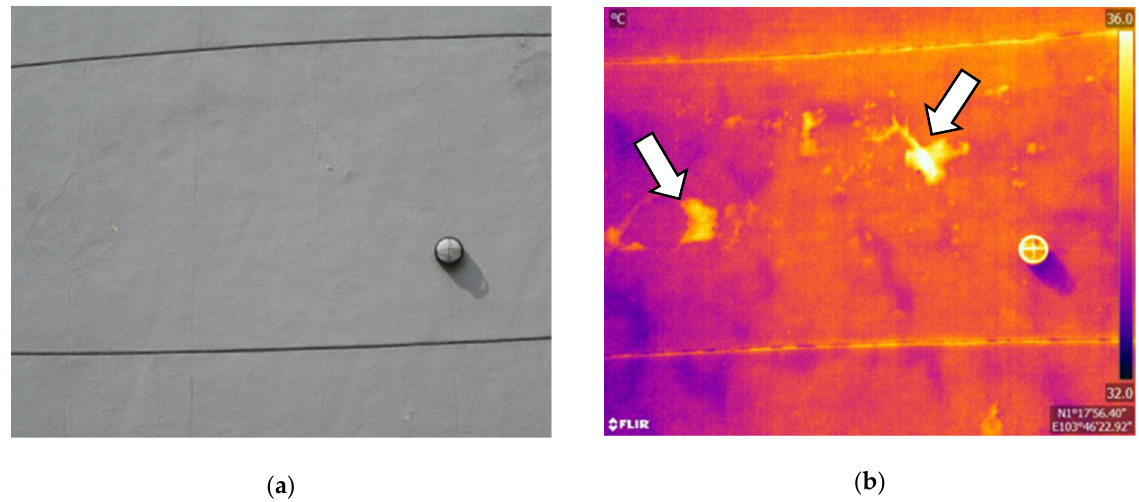
Figure 3. An example showing images of delamination on a building wall during heating cycle: ( a ) visual image; ( b ) IR image. Arrows indicate delamination areas.